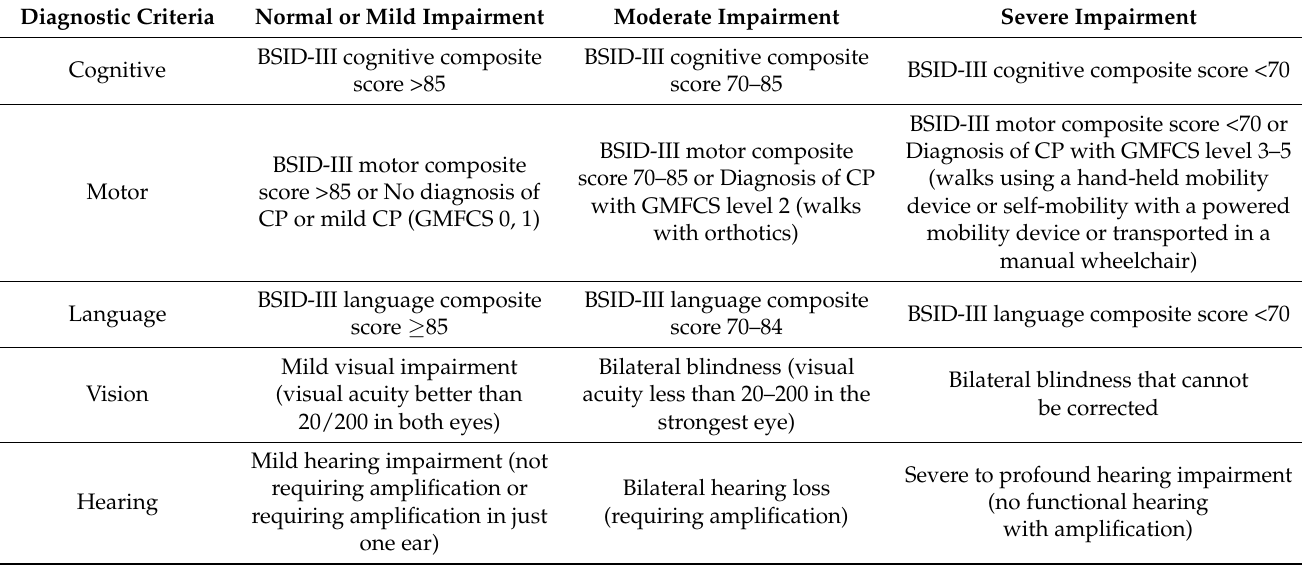
Table 1. Categorization of neurodevelopmental outcome measures by 18–24 months corrected age. Diagnostic